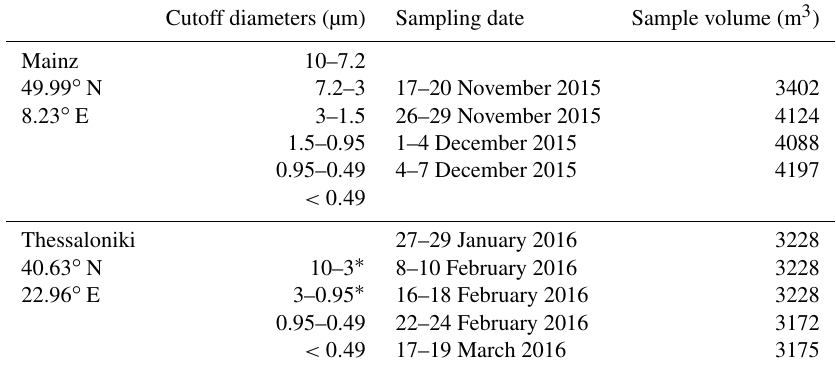
Table 1. Sampling